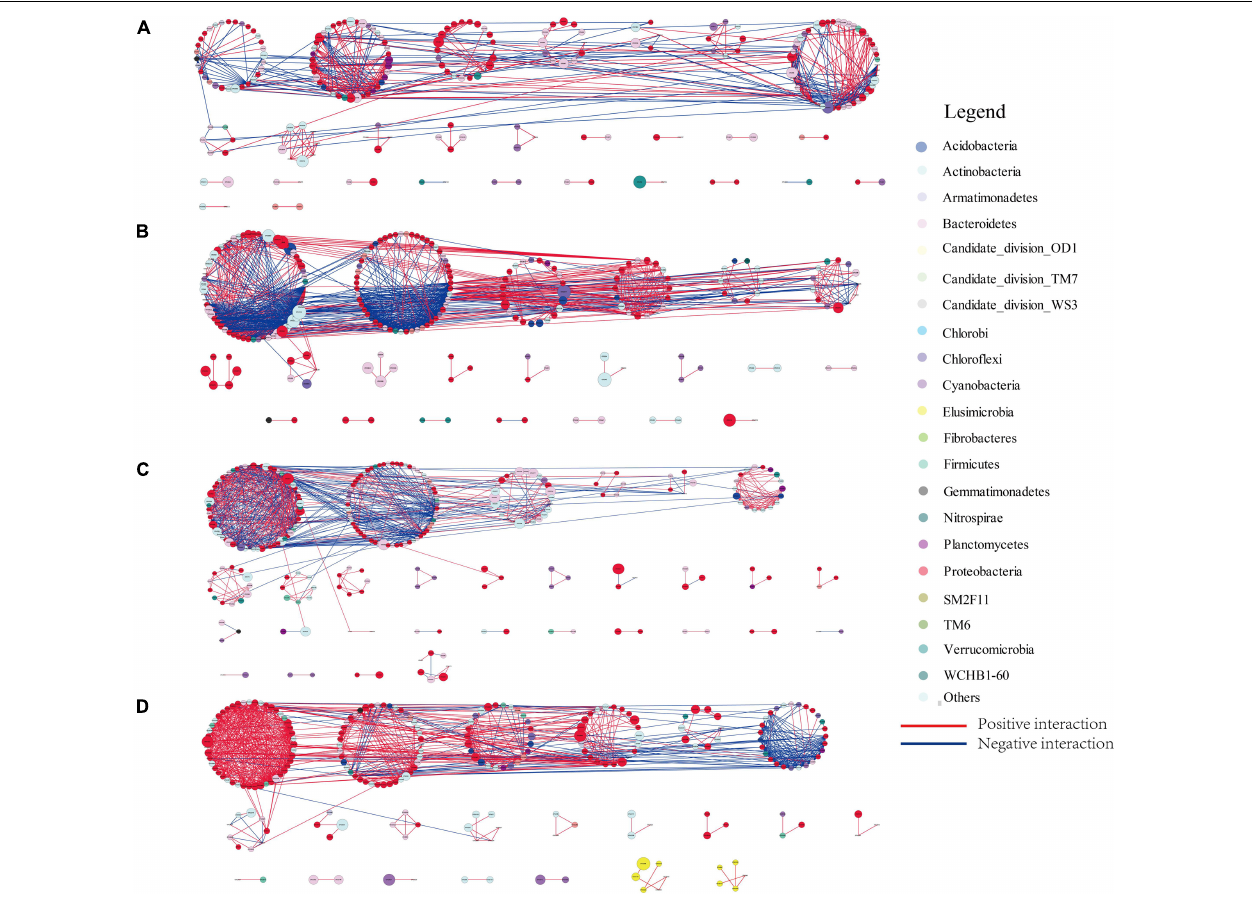
FIGURE 6 | Overview of the 2018S (A) , 2018A (B) , 2019S (C) , 2019A (D) bacterioplankton networks. Each node represents an OTU. The colored circles indicate the OTUs affiliated with particular phyla (color code on the